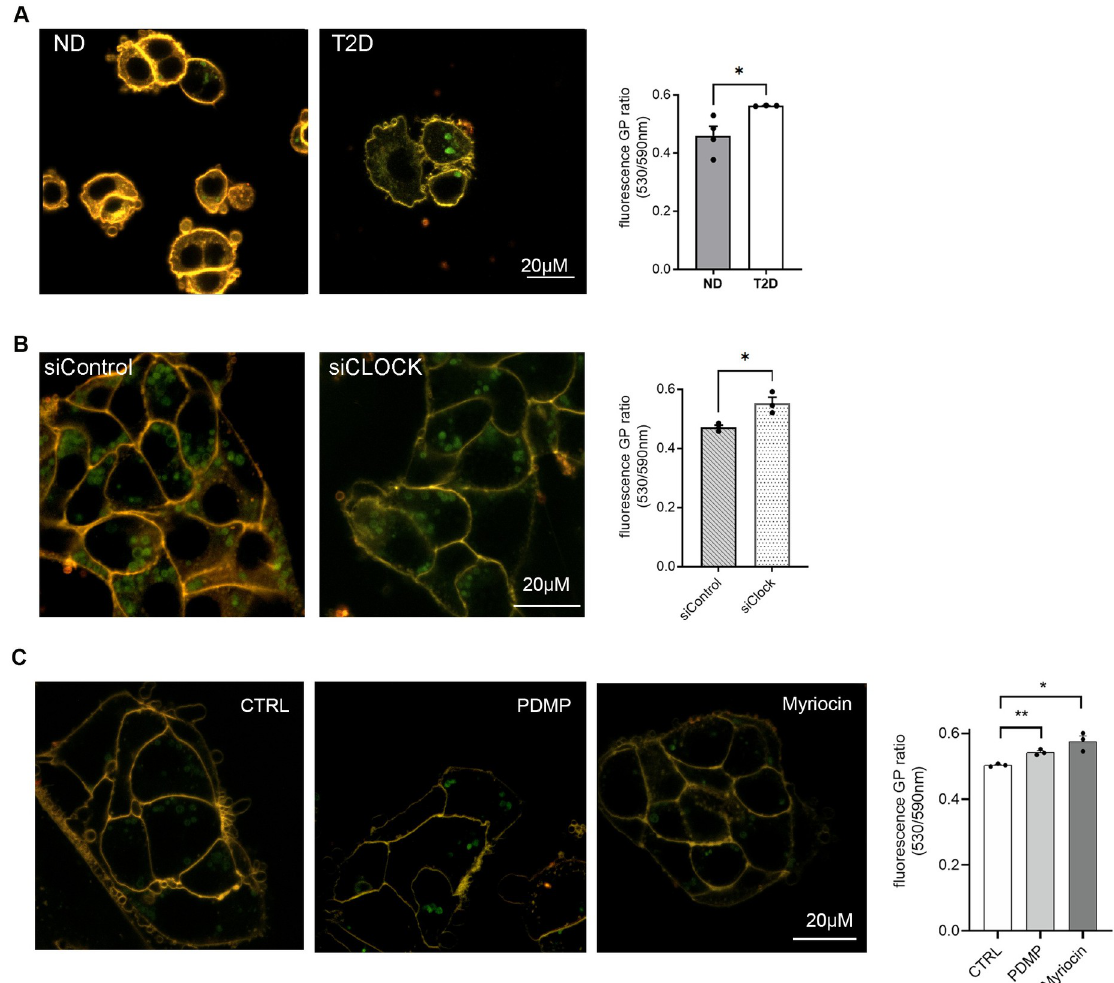
Fig 5. Lipid membrane fluidity of the human pancreatic islet cells is attenuated in T2D islets, in ND islets upon siClock-mediated clock disruption, and in ND islets following perturbation of ceramide metabolism by PDMP or myriocin. Live cell imaging of human islet cells stained with NR12S dye. (A) Representative ND (left) and T2D (right) human islet cells. The graph on the right summarizes the quantification of fluorescence GP ratio for n = 4 ND and n = 3 T2D donors. (B) Representative images of ND islet cells transfected with scrambled siRNA ( siControl , left) bearing functional clocks and siClock targeting CLOCK protein that bear perturbed oscillators (right). The graph on the right summarizes the quantification of fluorescence GP ratio for n = 3 donors. (C) Representative images of nontreated control ND islet cells (left), cells following 1-h treatment with PDMP (middle) or myriocin (right). The graph summarizes the quantification of fluorescence GP ratio for n = 3 human donors. Note the significant up-regulation of membrane rigidity for T2D islet cells (A), ND cells with compromised clocks (B, siClock ), and ND cells with impaired sphingolipid metabolism (C, PDMP and myriocin). Graph data are represented as mean ± SEM; unpaired 2-tailed t test as compared to control, p � < 0.05, p �� < 0.01. See also S3 Fig and S4 Data. GP, generalized polarization; ND, nondiabetic; siRNA, small interfering RNA; T2D, type 2 diabetes.